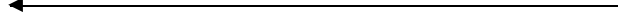
Fig. 3a–c. The filtered tidal amplitude data for: a 2.5-day wave in the amplitudes of the diurnal meridional tide in January–March